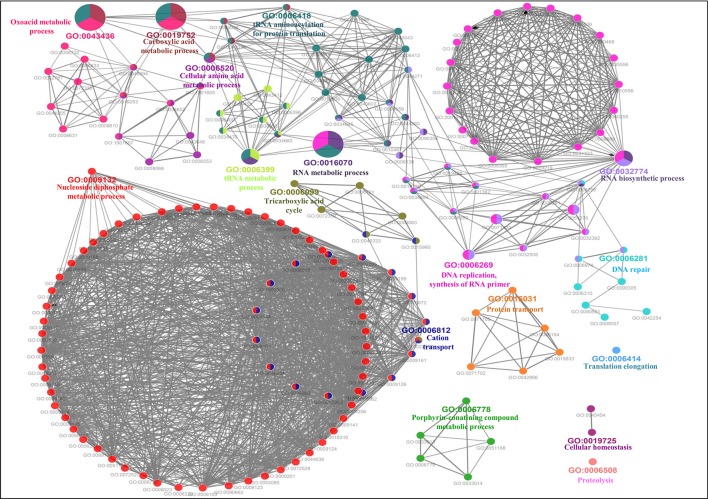
Gene Ontology biological process network of putative MBPs. Functionally enriched GO biological process network of predicted MBPs in Ott was computed by ClueGO (at kappa score ≥0.4). Each circle symbolizes a node, i.e., specific GO biological term. The node color designates a specific GO group. The mixed color of the node indicates that specific node is involved in multiple biological processes. A total of 17 GO biological groups were found in the network, and among them, seven were significant with GO biological terms [oxoacid metabolic process (GO:0043436), carboxylic acid metabolic process (GO:0019752), cellular amino acid metabolic process (GO:0006520), tRNA metabolic process (GO:0006399), RNA metabolic process (GO:0016070), RNA biosynthetic process (GO:0032774), and DNA replication, synthesis of RNA primer (GO:0006269)]. This network also supported our domain-based classification that most of the putative MBPs were functional in gene expression and regulation and metabolism.